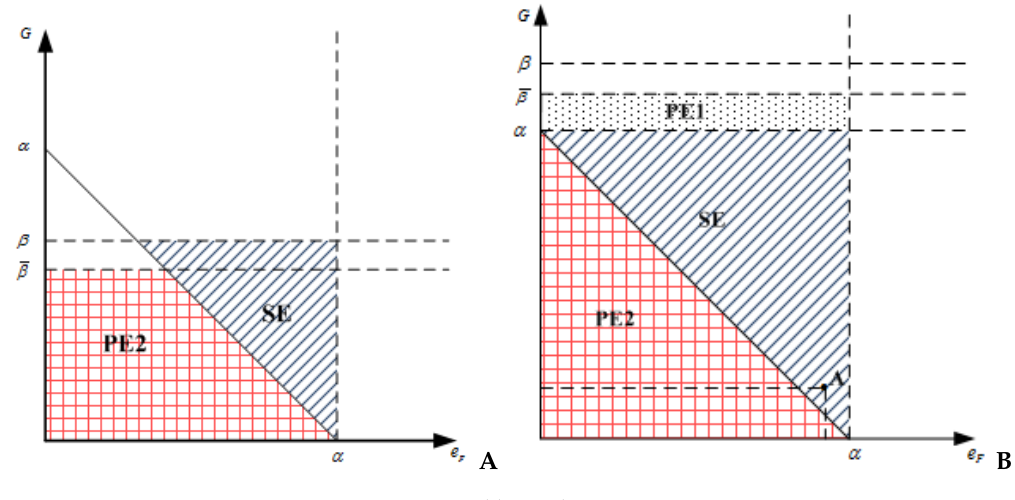
Figure 1. Equilibria when β > α